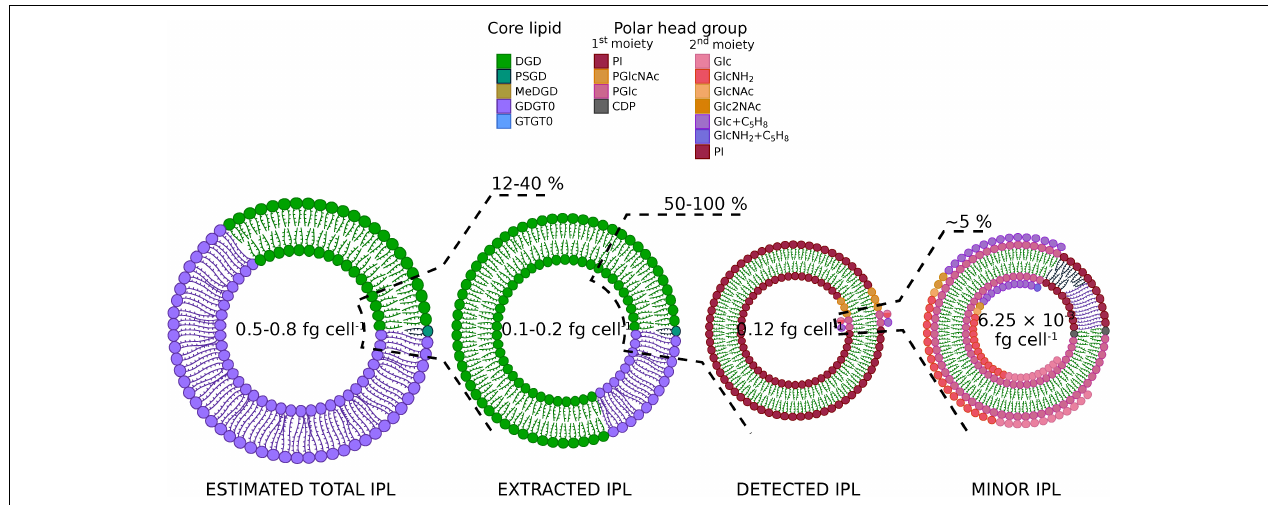
FIGURE 4 | The vast majority of Thermococcus barophilus ’ lipidome remains inaccessible. Pie chart representations of T. barophilus lipids at each extraction step. The direct acid methanolysis of T. barophilus biomass yielded its total core lipids content, which contained ca . 30% of diethers (DGD, green; PSGD, dark green; MeDGD, dark yellow) and 70% of tetraethers (GDGT0, purple; GTGT0, blue; Table 3 ). Considering putative low and high mass polar head groups found in archaea, the direct acid methanolysis of the biomass yielded an experimentally derived theoretical lipid content of 0.5 to 0.8 fg of lipids cell - 1 . An acid methanolysis of the TLE allowed the determination of the extraction yield on T. barophilus (0.1 to 0.2 fg cell - 1 considering putative low and high mass polar head groups, ca. 12–40% of the biomass’ total lipids) and of the diether and tetraether distribution in extracted lipids (80/20; Table 3 ). Although part of T. barophilus IPLs is indeed extracted, the majority of its IPLs, and especially tetraether-based ones, remain resistant to extraction. Eighteen IPLs representing 50–100% of these extracted lipids (0.12 fg cell - 1 ) were identified with UHPLC-MS ( Table 1 ). The putative discrepancy between extracted and identified IPLs highlights only a partial detection of T. barophilus IPLs with our UHPLC-MS system. Complex IPLs with at least two sugar residues (1 st and 2 nd polar head moieties) were recovered with an even lower yield, i.e., 6.25 × 10 - 3 fg cell - 1 , ca. 5% of the IPLs identified ( Table 1 ), thus showing that peculiar polar head groups might be the main reason for the detection defect observed in T. barophilus.